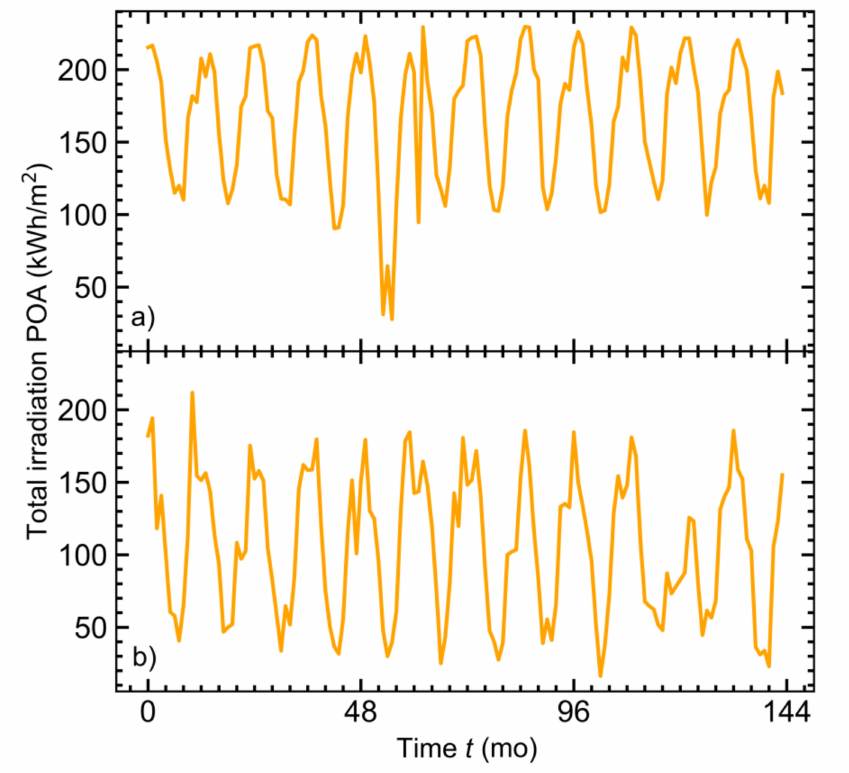
Figure 4. Monthly total irradiation at the plane of array (POA) in: ( a ) Nicosia, Cyprus; ( b ) Stuttgart, Germany over the 12-year evaluation